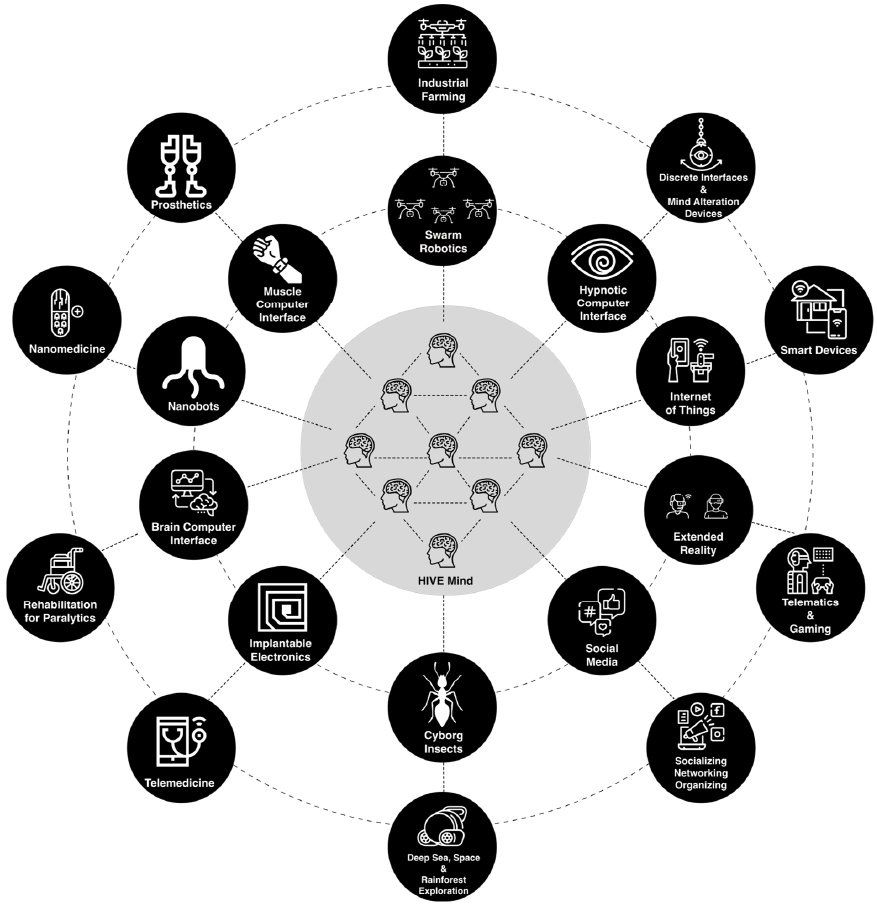
Figure 1. Information and technologies leading to the human-machine hive mind in the fu- ture.